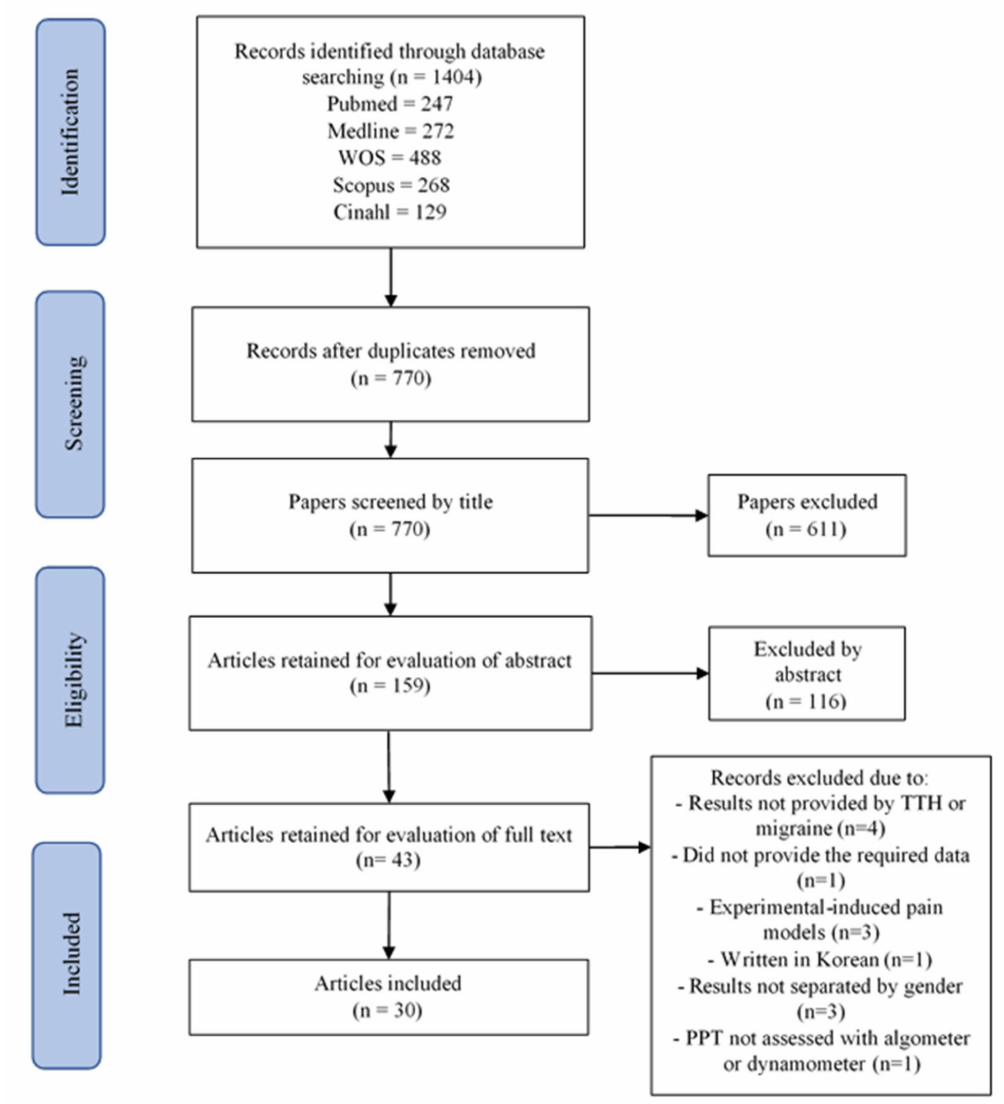
Figure 1. TTH process. PRISMA Extension for Scoping Reviews (PRISMA-ScR) flow